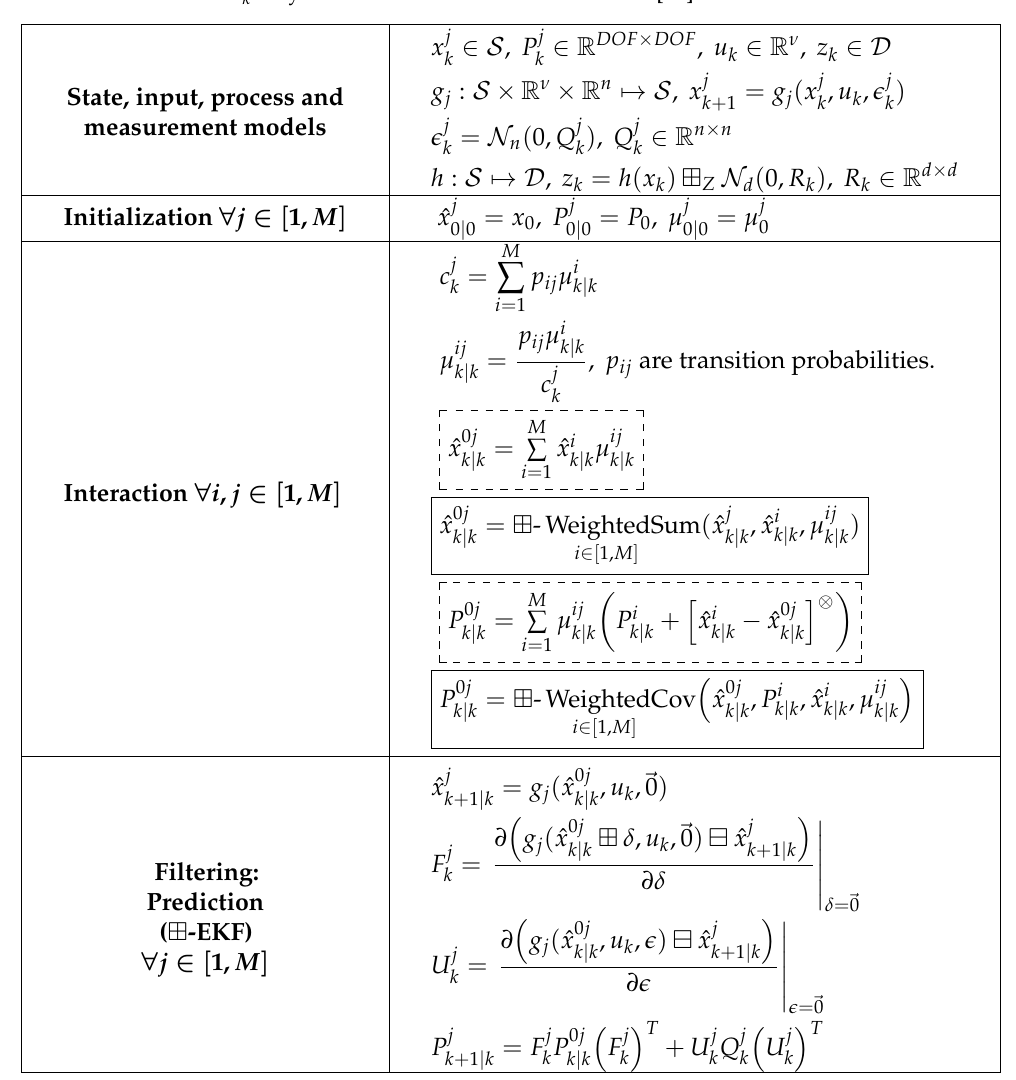
. Modified from [22]. D